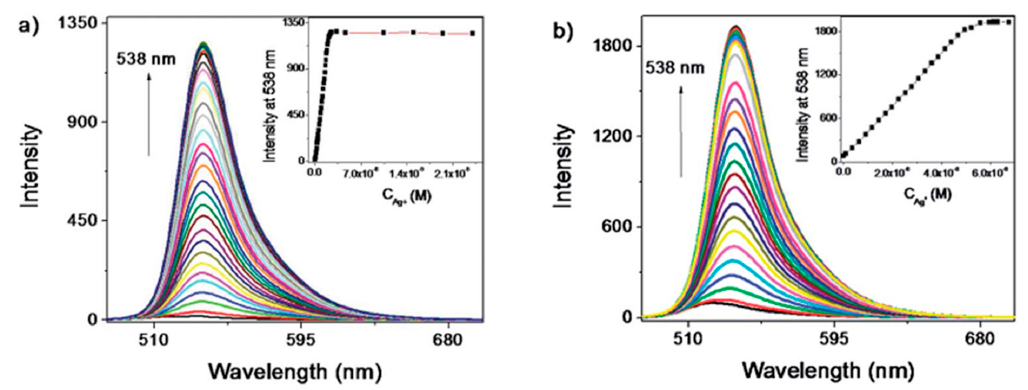
Figure 14. Fluorescence spectra of N,S- and N,Se-modified fluorescein sensors for different Ag + ions in ethanol. Reprinted with permission from [191]. Copyright 2014 Japan Society for Analytical Chemistry.